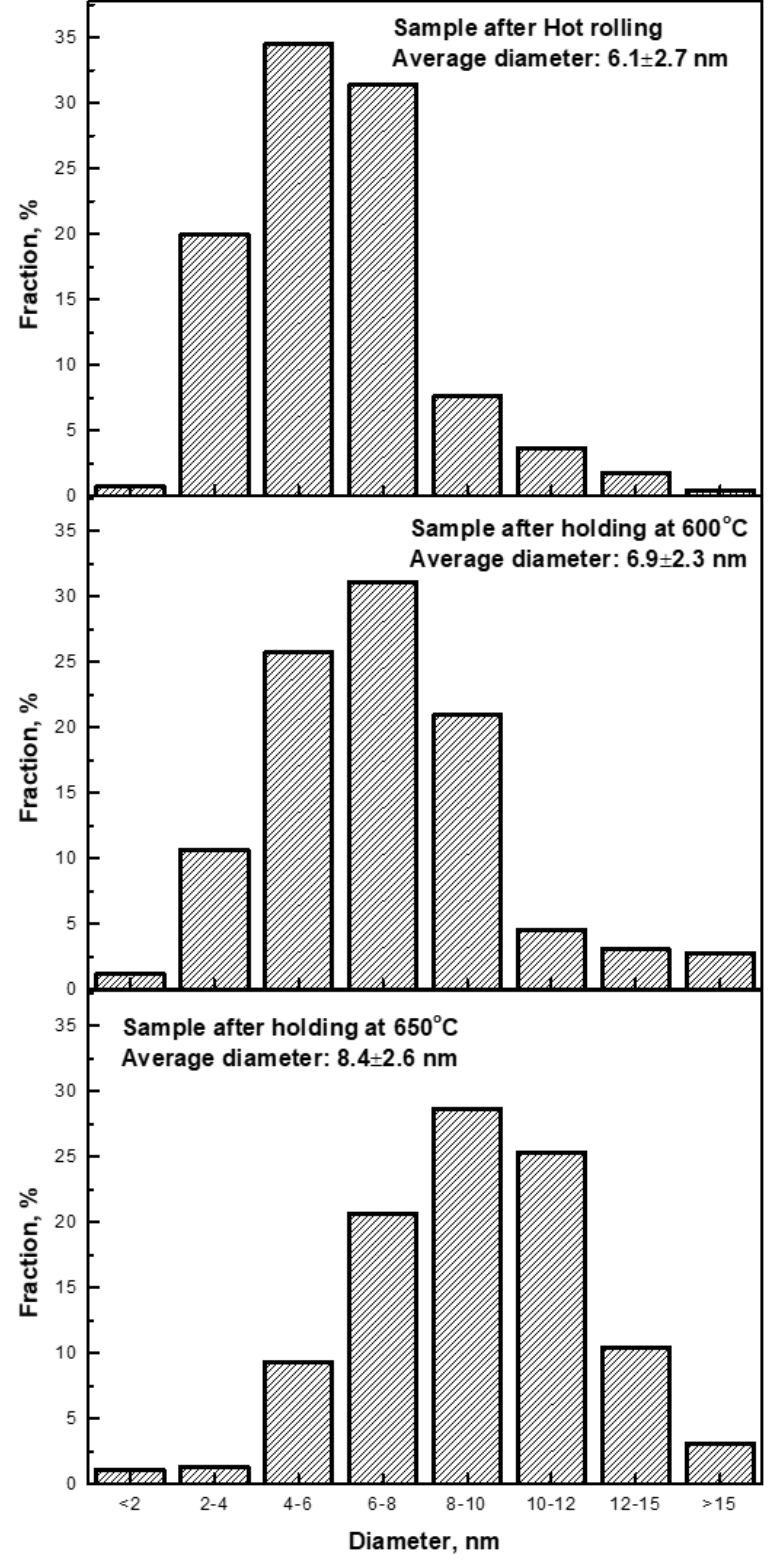
Figure 6. Size distributions of carbides for samples before and after holding at high temperatures.